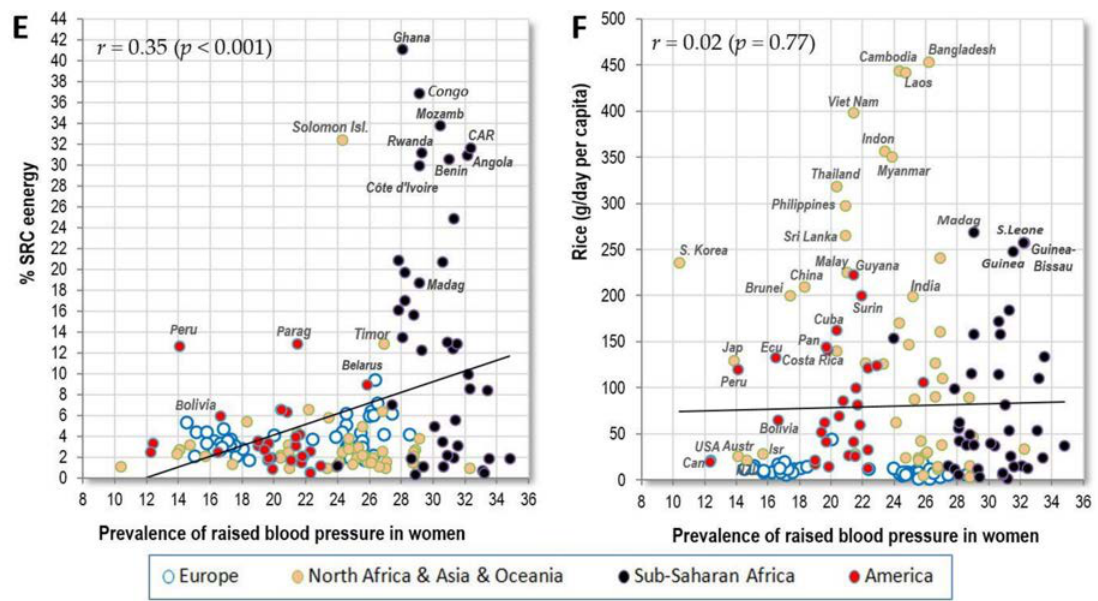
Figure 3. ( A ) Relationship between the prevalence of men’s raised blood pressure (%; WHO, 2010) and the mean proportion of carbohydrate energy from cereals and starchy roots (% CC energy and % SRC energy) in the diet (FAOSTAT, 1993–2011); ( B ) Relationship between the prevalence of women‘s raised blood pressure (%; WHO, 2010) and the mean proportion of carbohydrate energy from cereals and starchy roots (% CC energy and % SRC energy) in the diet (FAOSTAT, 1993–2011); ( C ) Relationship between the prevalence of women’s raised blood pressure (%; WHO, 2010) and the mean proportion of energy from carbohydrates and alcohol (% CA energy) in the diet (FAOSTAT, 1993–2011); ( D ) Relationship between the prevalence of women’s raised blood pressure (%; WHO, 2010) and the mean proportion of carbohydrate energy from cereals (% CC energy) in the diet (FAOSTAT, 1993–2011); ( E ) Relationship between the prevalence of women’s raised blood pressure (%; WHO, 2010) and the mean proportion of carbohydrate energy from starchy roots (% SRC energy) in the diet (FAOSTAT, 1993–2011); ( F ) Relationship between the prevalence of women’s raised blood pressure (%; WHO, 2010) and the mean consumption of rice (g/day per capita; FAOSTAT,